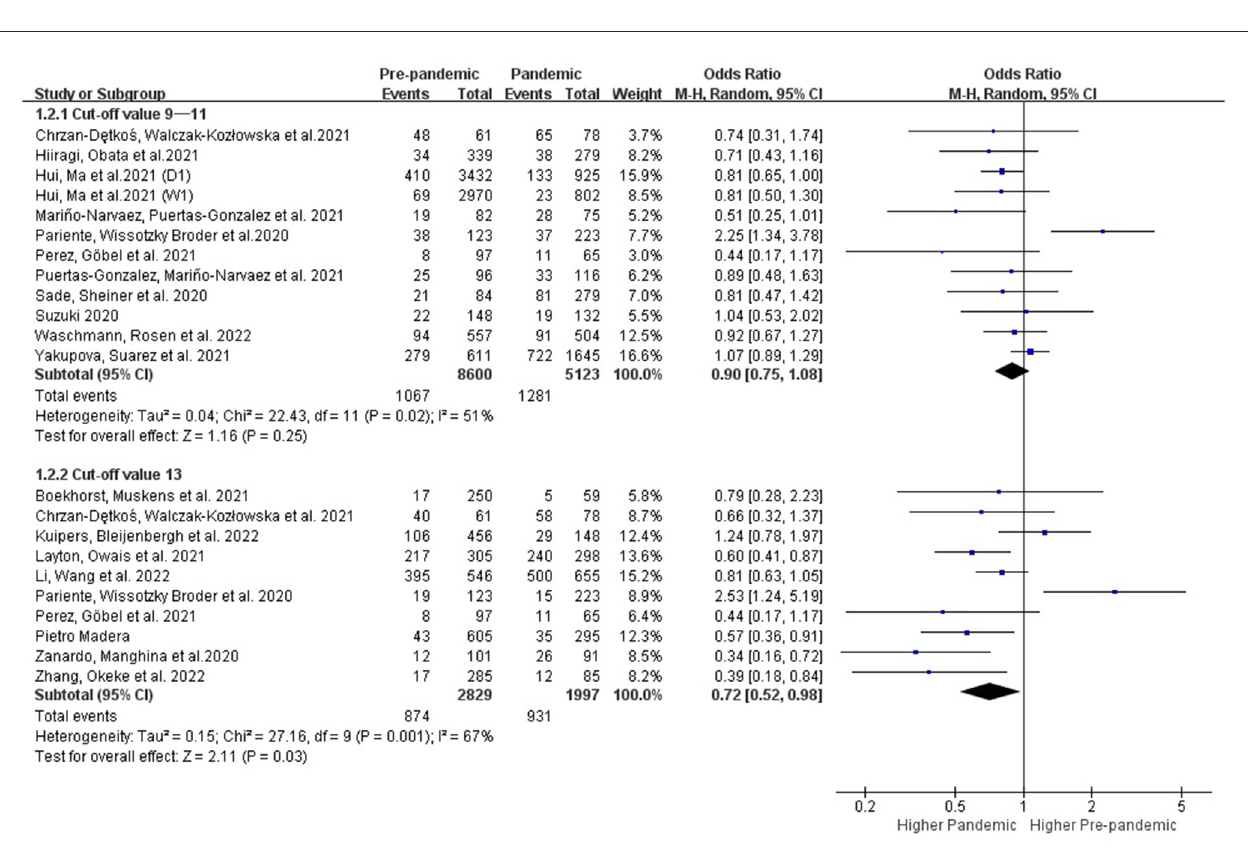
= 77%), while the prevalence of postpartum depression showed an obvious increase when detected after the first 2 weeks during the COVID-19 period (OR: 0.81 [0.68, 0.97], P = 0.02, I 2 = 43%) (Figure